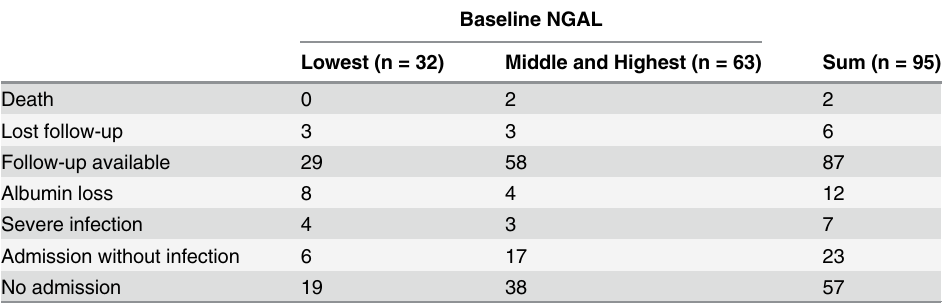
Table 5. Clinical course of HD patients during a year of follow-up.